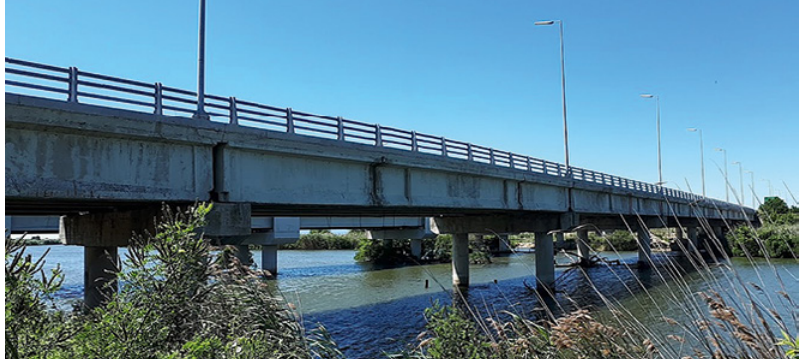
Figure 1. The Strimonas Bridge (Panetsos, 2017)